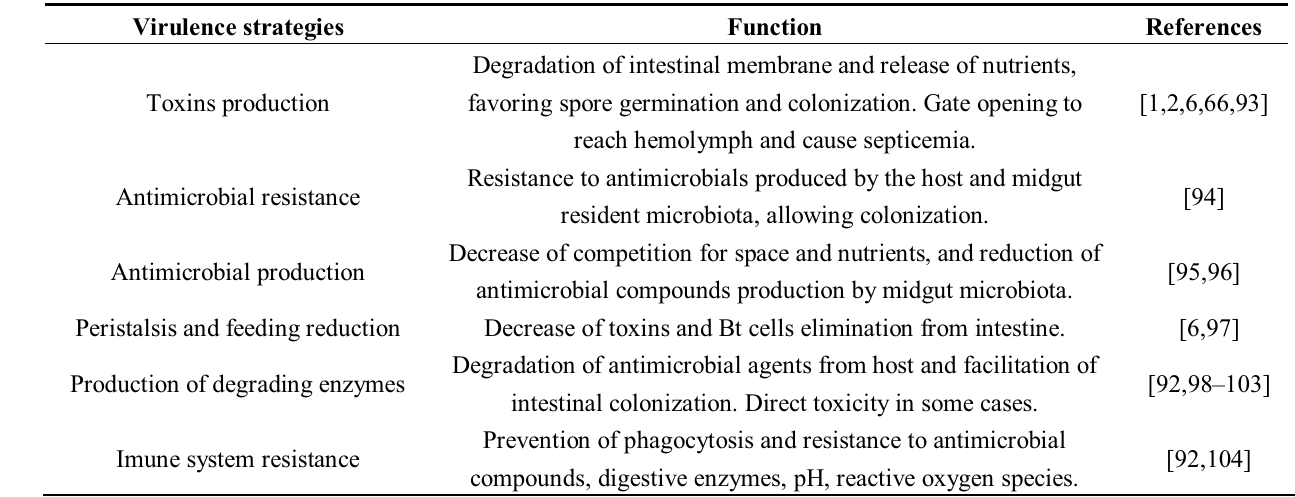
Table 1. Virulence strategies found in Bacillus thuringiensis and their